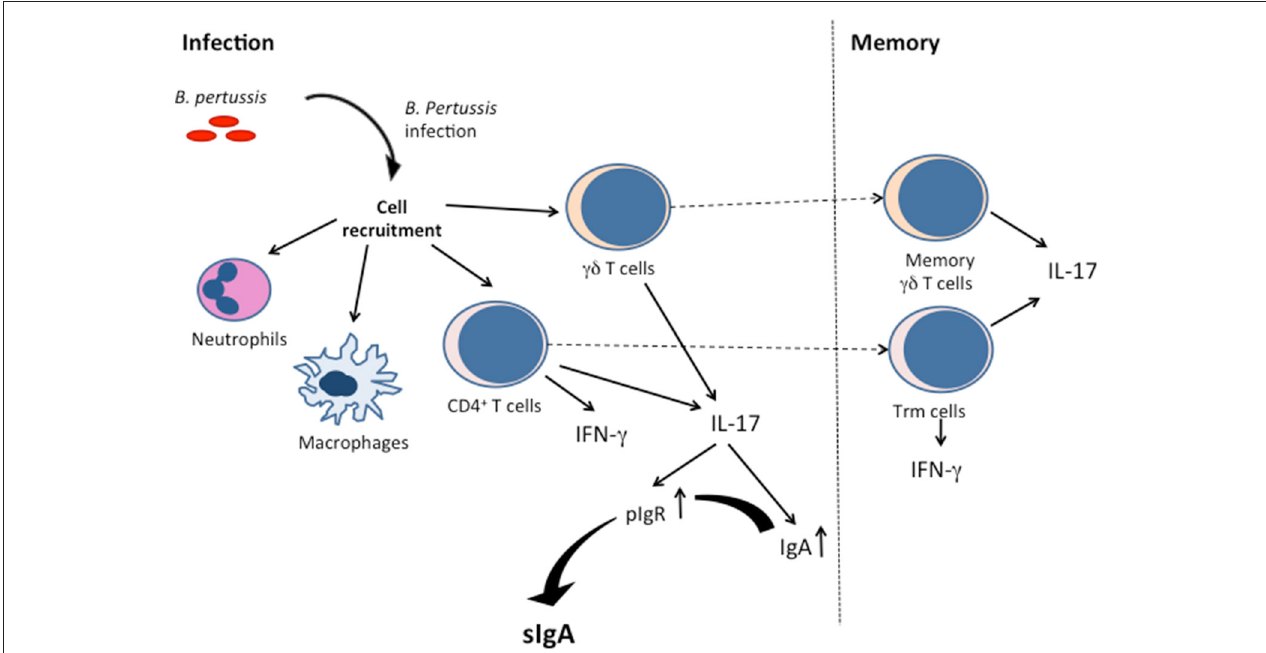
FIGURE 1 | Cellular immune responses and induction of sIgA by B. pertussis infection. B. pertussis infection induces innate immune cell (such as neutrophils and macrophages) activation, as well as IFN- γ -producing and IL-17-producing T cells. The Th-17T cells are instrumental for sIgA production. The infection also results in resident memory T cells ( γδ and CD4 + T